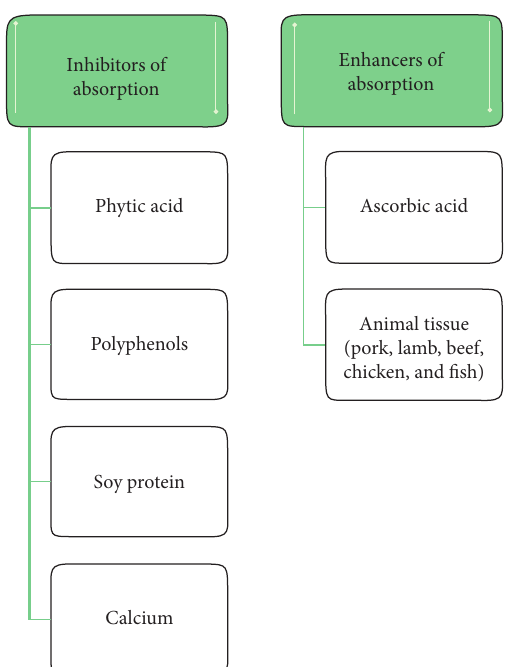
Figure 1: Factors that increase and reduce the absorption of iron